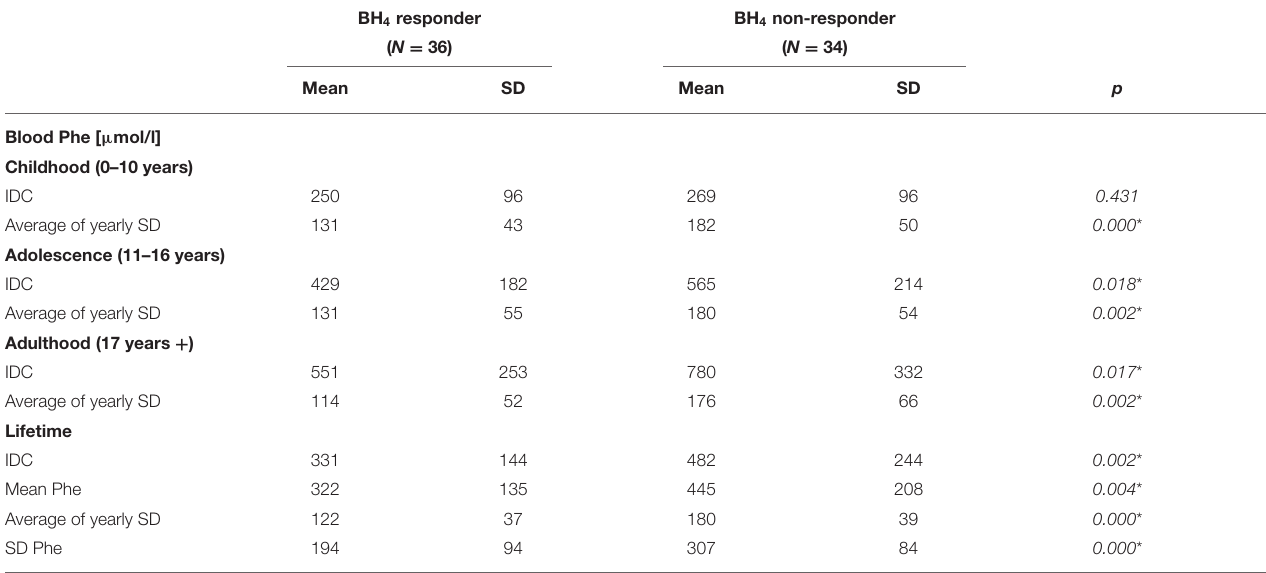
TABLE 2 | Phenylalanine indices of BH 4 responsive and non-responsive ETPKU patients. BH 4 responder BH 4 non-responder